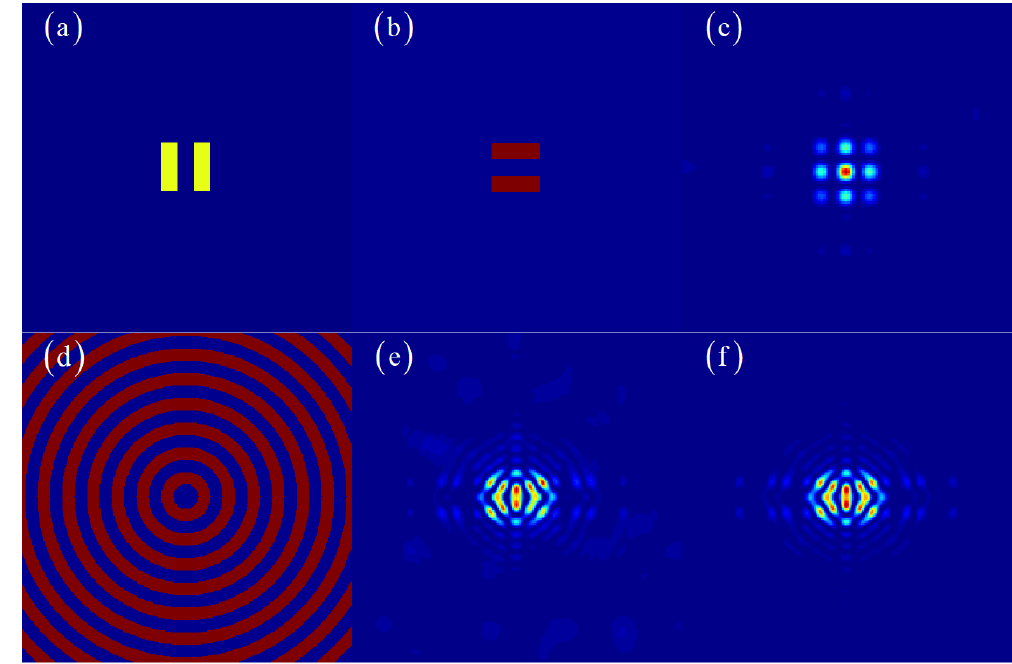
Figure 6. Simulation results of X-ray Fourier-transform GISC. ( a ) is the sample, ( b , d ) are the masks, ( c , e ) are the non-locally encoded X-ray Fourier-transform GISC diffraction patterns reconstructed from the intensity correlations with ( b , d ) inserted in the reference path, respectively. ( f ) is the corresponding coded diffraction pattern obtained from the coherent diffraction imaging